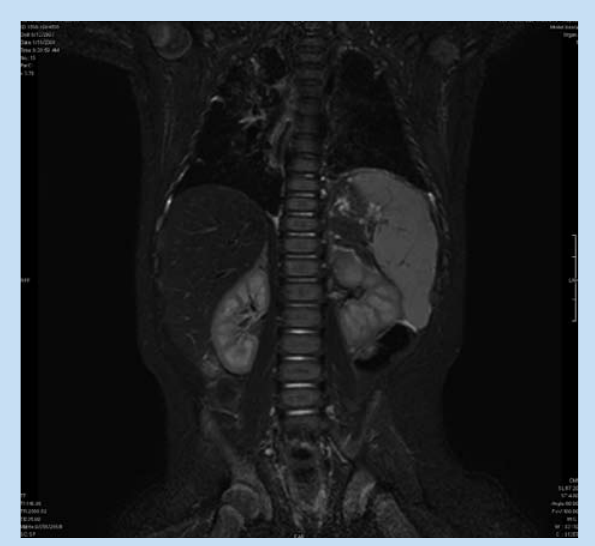
Fig. 5a. Flush aortogram demonstrating extensive arterial supply, including branches from intercostal arteries (arrows).